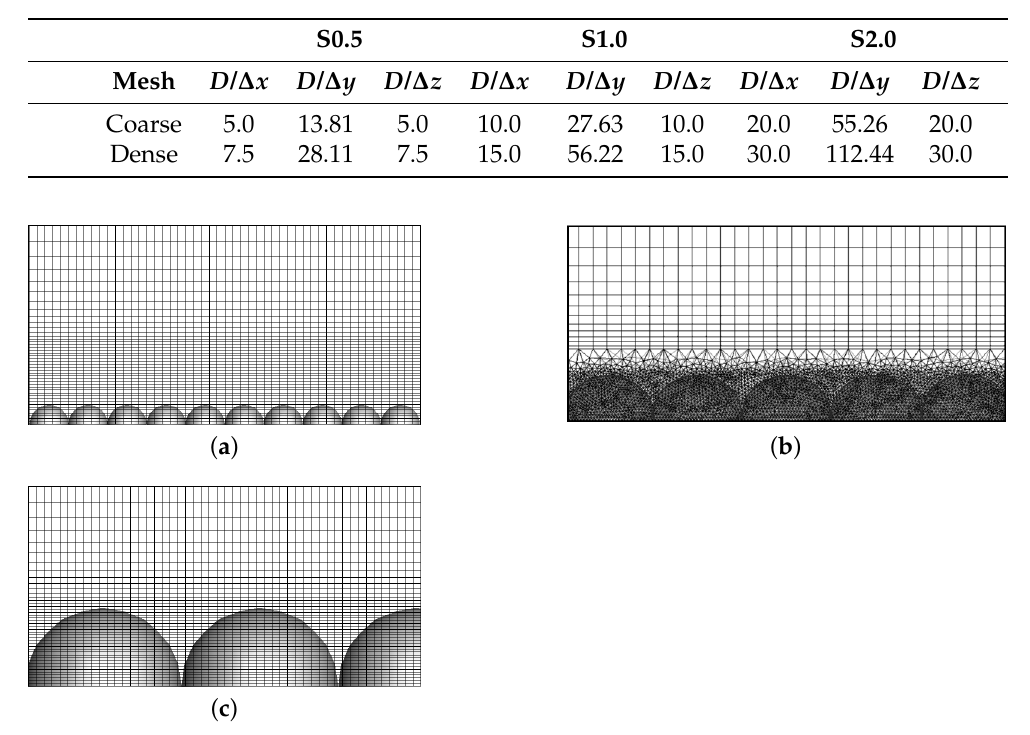
Table 1. Characteristics of the computational meshes.